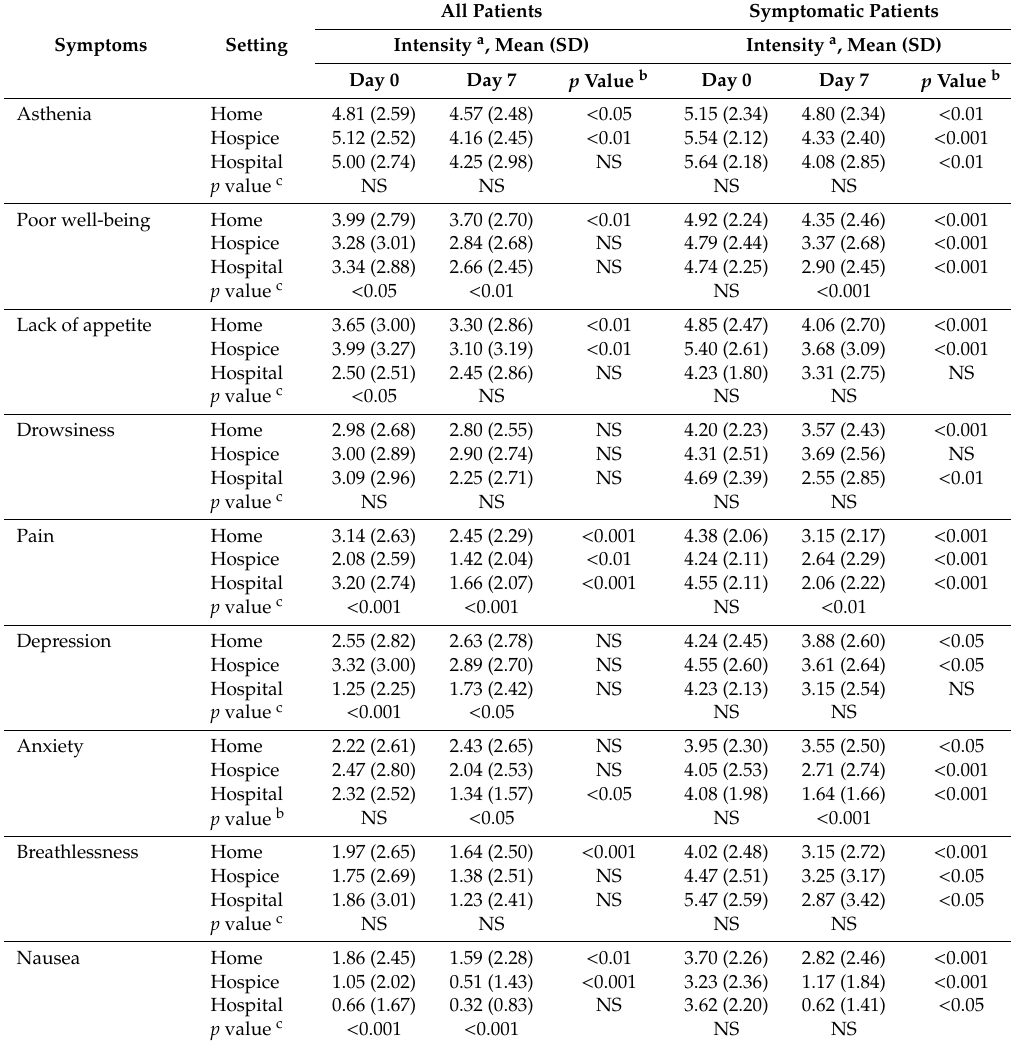
Table 6. Changes in intensity of the main symptoms between day 0 and day 7 according to the setting of care in 508 patients overall and in those symptomatic at